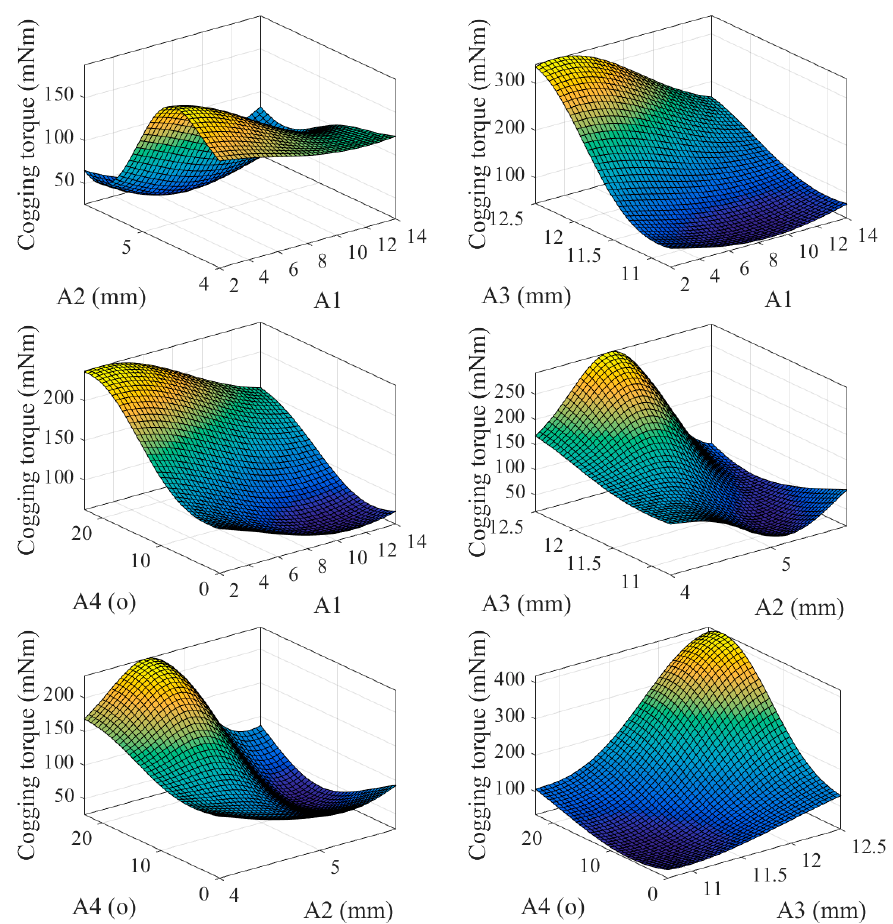
Figure 8. The response surface results of the relationship between the two factors.